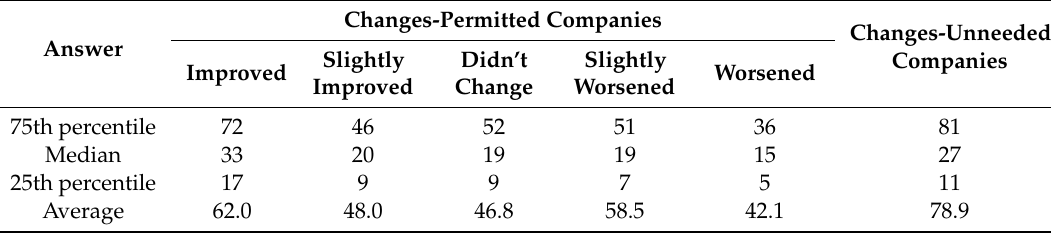
Table 4. Number of full-time employees (latest accounting period) (unit: